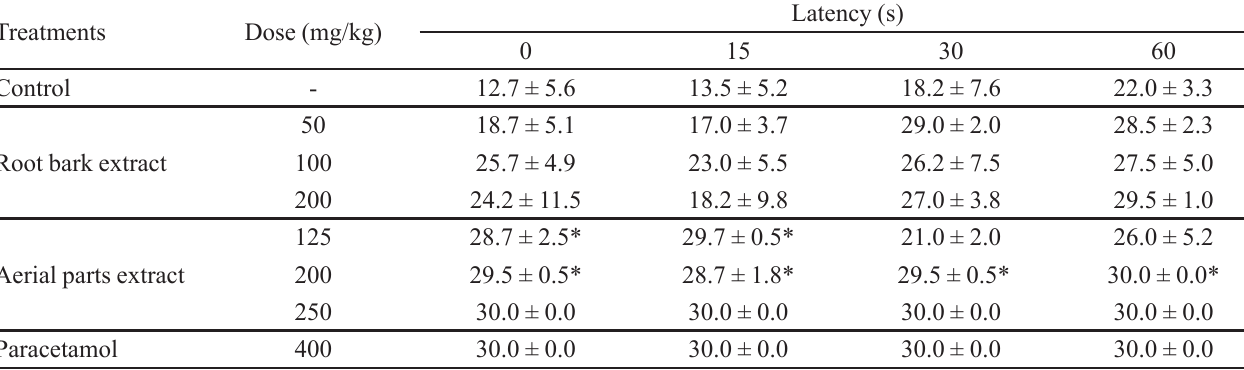
Aerial parts extract Paracetamol Values are expressed as mean ± standard deviation. N =10. (*) Statistically different from controls, p<0.05 (ANOVA/Tukey’s